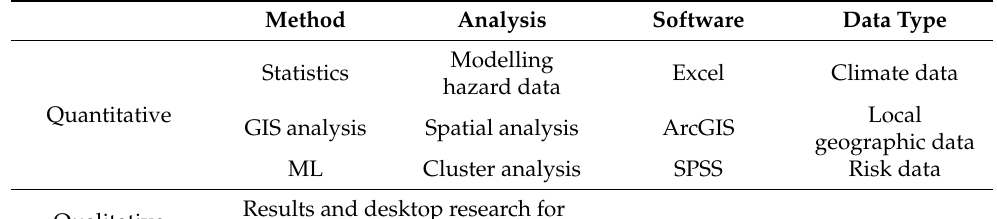
Table 2. Research approach for this study.